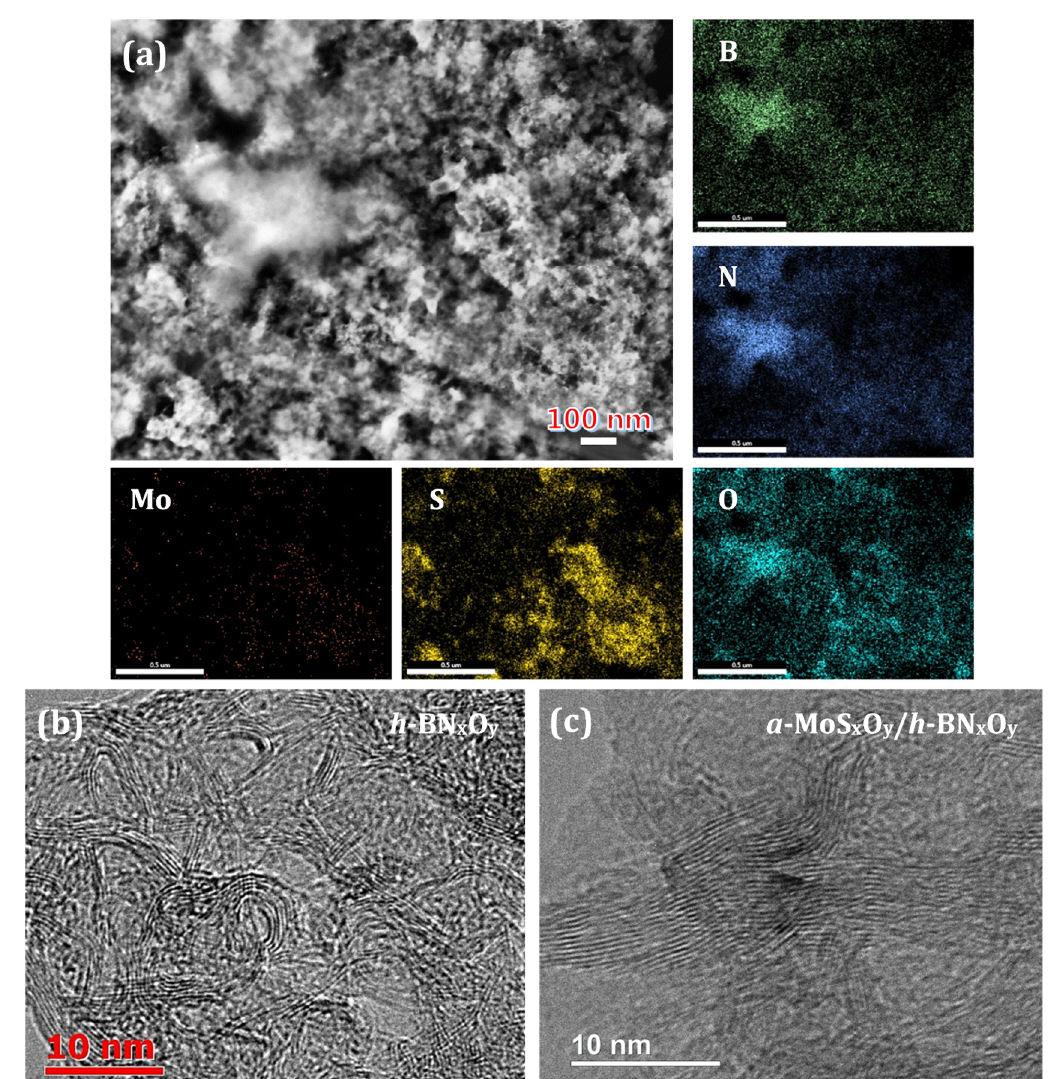
Figure 1. HAADF-STEM image with corresponding EDXS elemental maps of the as-synthesized a -MoS x O y / h -BN x O y nanohybrids ( a ). High-resolution TEM micrographs of the pristine h -BN x O y ( b ) and as-synthesized a -MoS x O y / h -BN x O y nanohybrids ( c ).